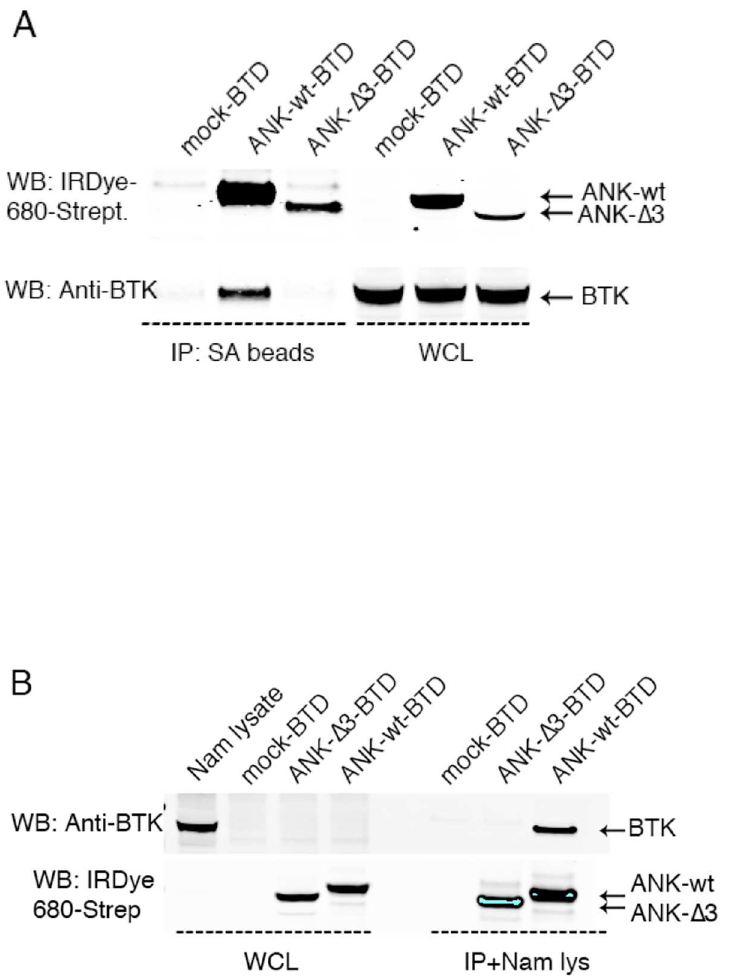
Fig 2. Characterization of the high-affinity ANKRD54/BTK interaction. (A) Transfection by electroporation of Namalwacellsand (B) transiently-transfected Cos7 cell lysate mixed with Namalwa(Nam) lysate, followed by co-immunoprecipitation (IP) of endogenous BTK. The missingexpressionof BTK from the wholecell lysate (WCL) of untransfected Cos7 cells (lane1) shows that these cells do not expressBTK.